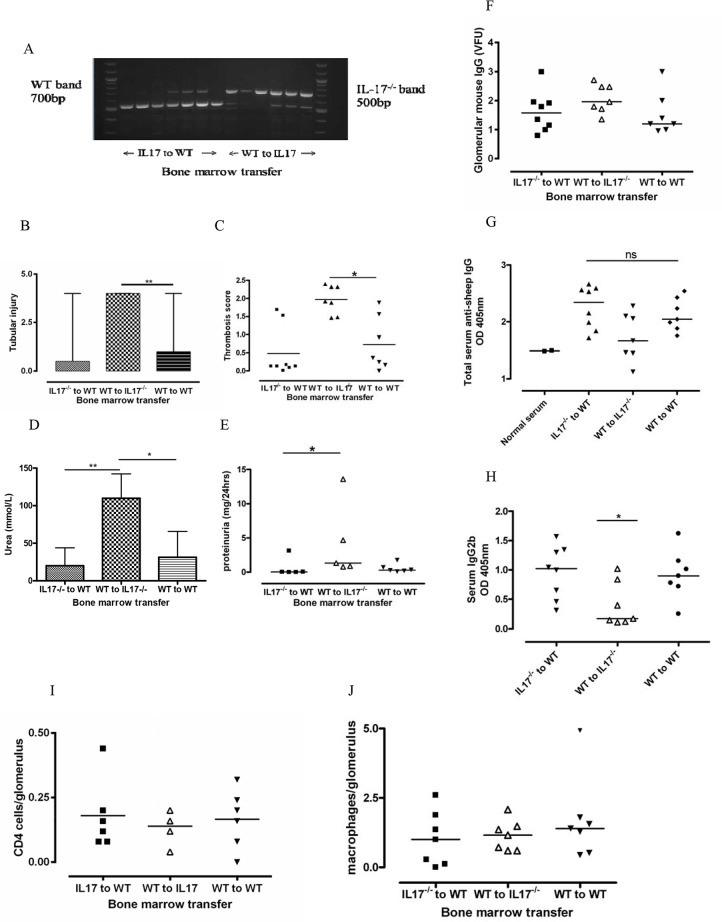
Transplantation of WT bone marrow to IL-17-/- mice restores and augments disease susceptibility.(A) Haematopoietic reconstitution of bone marrow transplant mice. DNA extracted from blood was analysed by PCR for WT and IL-17-/- alleles. All mice reconstituted >90% donor bone marrow. WT to IL-17-/- mice have (B) significantly greater tubular injury (p<0.01) and (C) more glomerular thrombosis (p<0.05) than WT to WT mice. Renal function is worse as measured by serum urea (D) than the other two groups. WT to IL-17-/- mice had more proteinuria than IL-17-/- to WT mice (p<0.05) (E), but not statistically more than WT to WT mice due to small numbers, many of the severely affected mice were oligo-anuric and produced insufficient urine to quantify. Humoral immune responses and infiltrating cell numbers were similar between the groups despite differences in disease outcomes. (F) There was no difference in glomerular mouse IgG between the groups. (G) Serum showed no differences in total anti-sheep IgG produced. (H) There was significantly less IgG2b in WT to IL-17-/- mice in the first experiment and a similar tendency in the second experiment. There was no difference in numbers of (I) CD4+ T cells or (J) CD68+ macrophages in the glomeruli. Analysis by Two-Way ANOVA and non-parametric Mann-Whitney U test. Bars represent median and range. Lines represent median. * = p<0.05; ** = p<0.01; *** = p<0.001. Representative data shown from 1 experiment of 2 separate experiments of at least 6 mice per group.